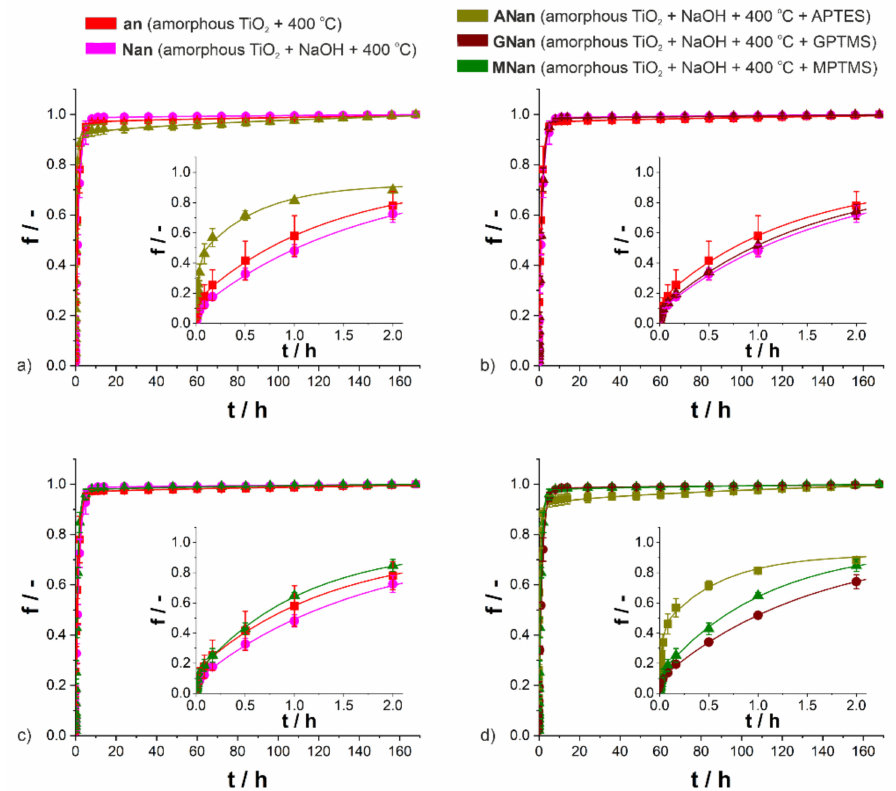
Figure 4. Drug release profiles of ibuprofen from the non-modified (an) and modified (Nan, Anan, GNan, and MNan) TiO 2 samples with the fitted DDD model (( a ) an, Nan, and Anan; ( b ) an, Nan, and GNan; ( c ) an, Nan, and MNan; ( d ) ANan, GNan, and MNan). Insets show the first 2 h of the release process (the standard deviations of the means, represented as bars, were calculated for n = 3). As expected, biphasic release behavior was observed for all types of systems (Figure